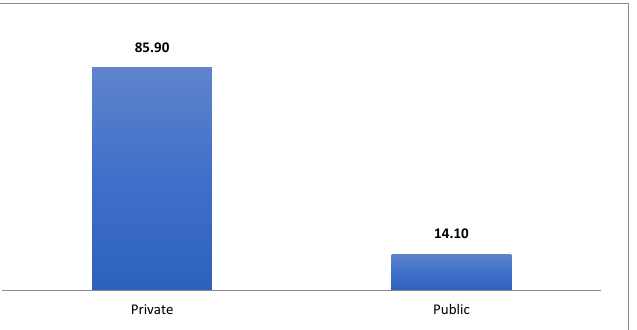
Figure 5. Dental Care Facilities in Romania (%). Source: computed by the authors using the database [28,29].